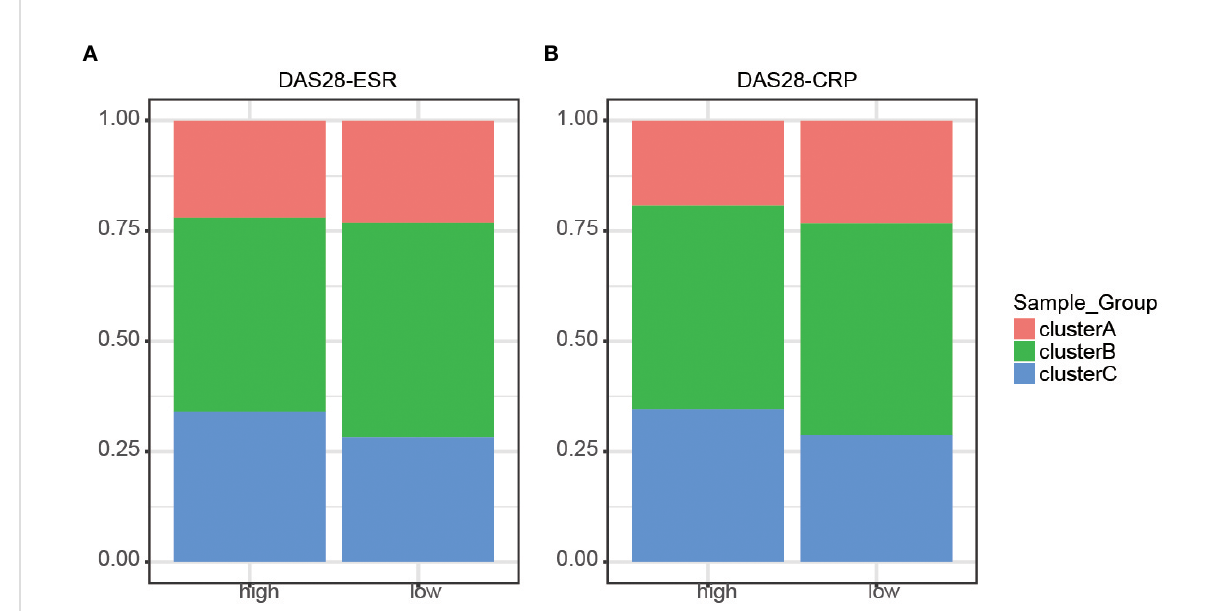
FIGURE 4 Distribution of disease activity scores between clusters. (A) DAS28-ESR showed no discrepancies identi fi ed in the three m6A clusters (P > 0.05). (B) DAS28-CRP showed no discrepancies identi fi ed in the three m6A clusters (P >